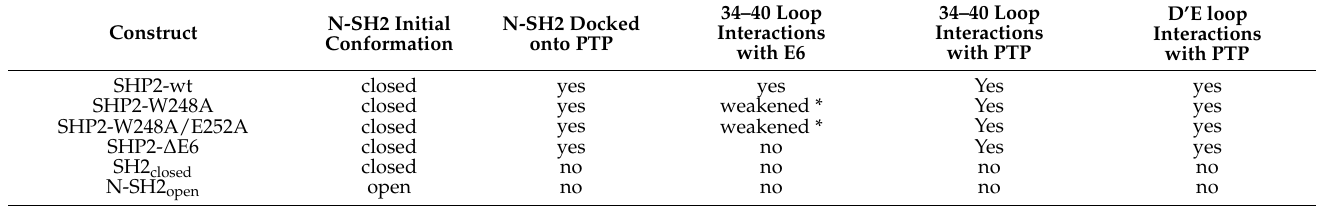
Table 1. Summary of the main features characterizing the various structural contexts of the N-SH2 domain in the constructs explored by MD